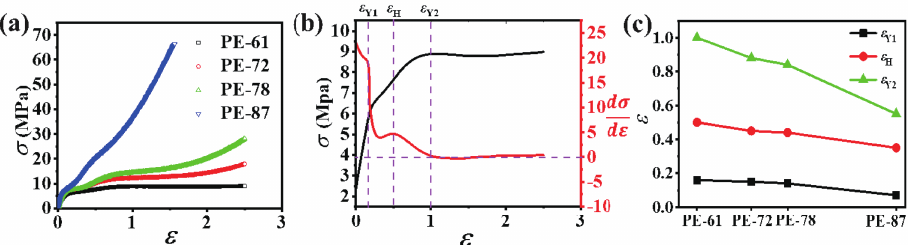
Figure 2. ( a ) Engineering stress–strain curves of mLLDPE precursor films with different orientations; ( b ) the first derivative of the stress–strain curve of PE-61 together with the definition of the double yield points and the strain hardening point; ( c ) the double yield points and the strain hardening point for four different mLLDPE precursor